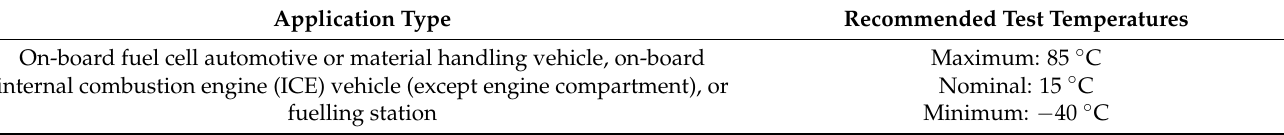
Table 7. Reference temperatures for selected applications